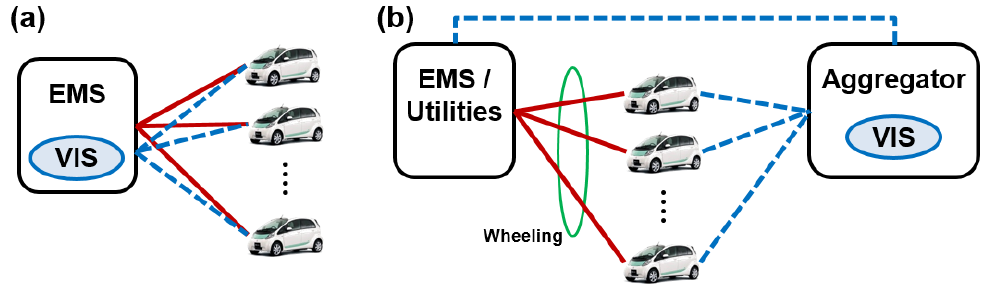
Figure 2. Possible utilization schemes of EV to support grid electricity: ( a ) direct utilization scheme; ( b ) aggregator-based utilization